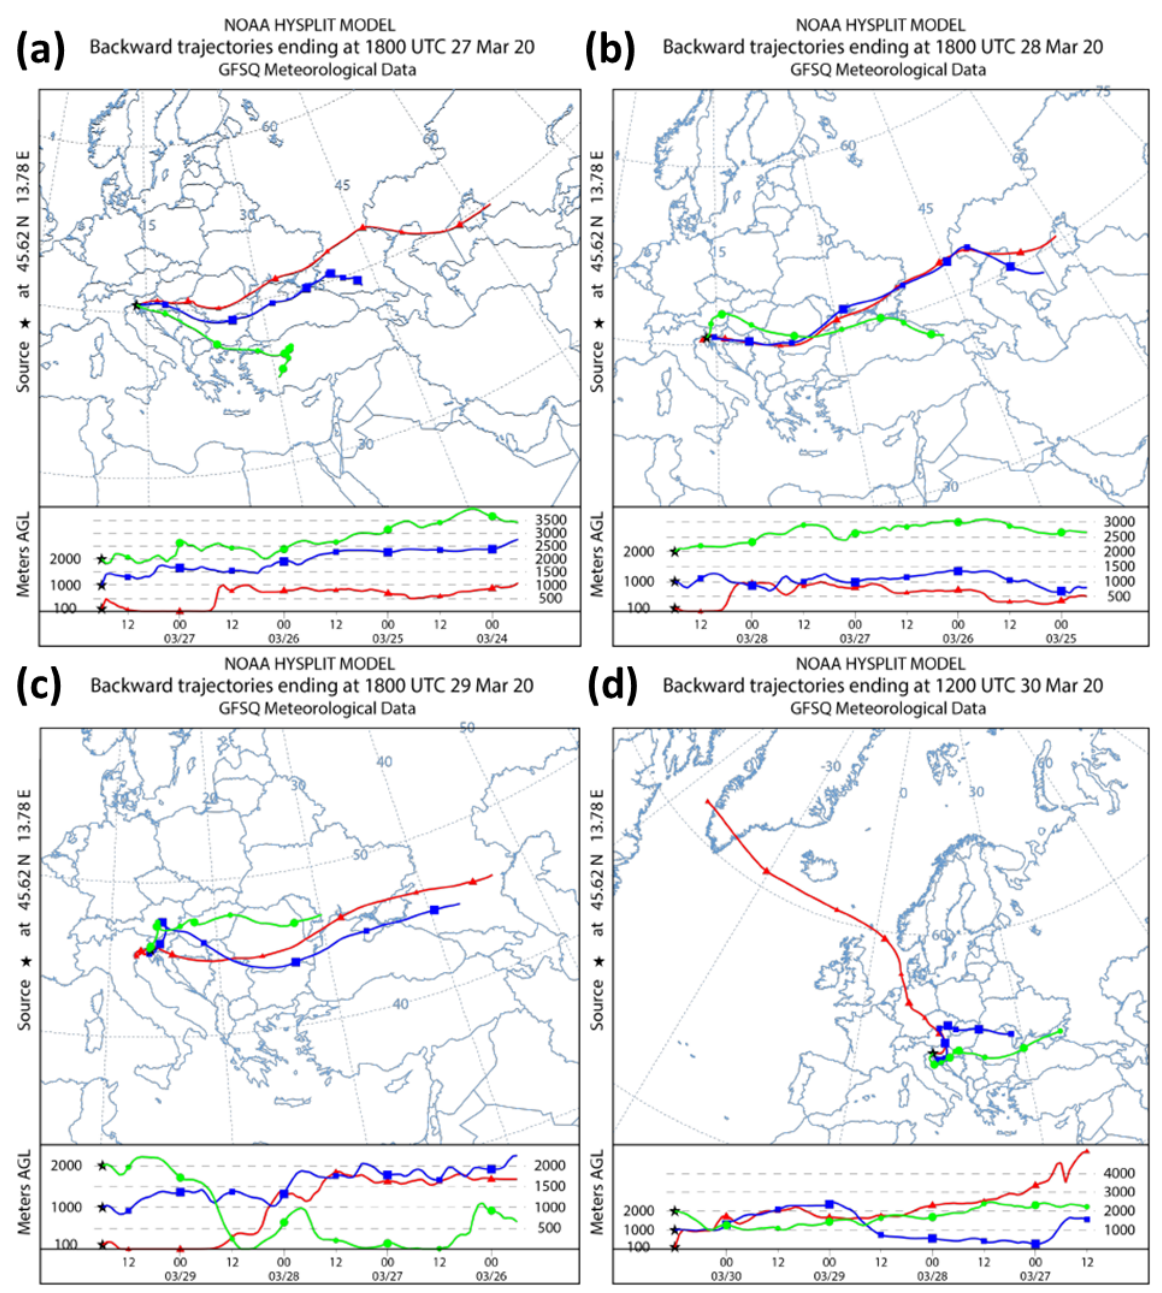
Figure A2. Back trajectories (96h backwards) ending at Trieste on (a) 27 March at 18:00UTC, (b) 28 March at 12:00UTC, (c) 29 March at 18:00UTC, and (d) 30 March at